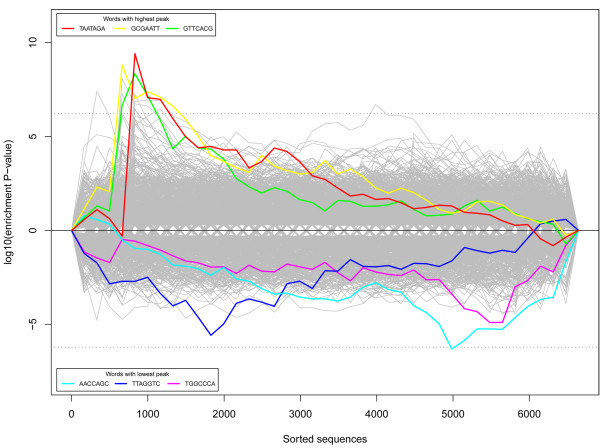
The word enrichment and depletion pattern in mRNA 3' UTR. Genes are sorted by their expression divergence between normal and cold-acclimated zebrafish (from the most up-regulated to the most down-regulated). Probability values with a plus-sign are enriched; those with a minus-sign are depleted.